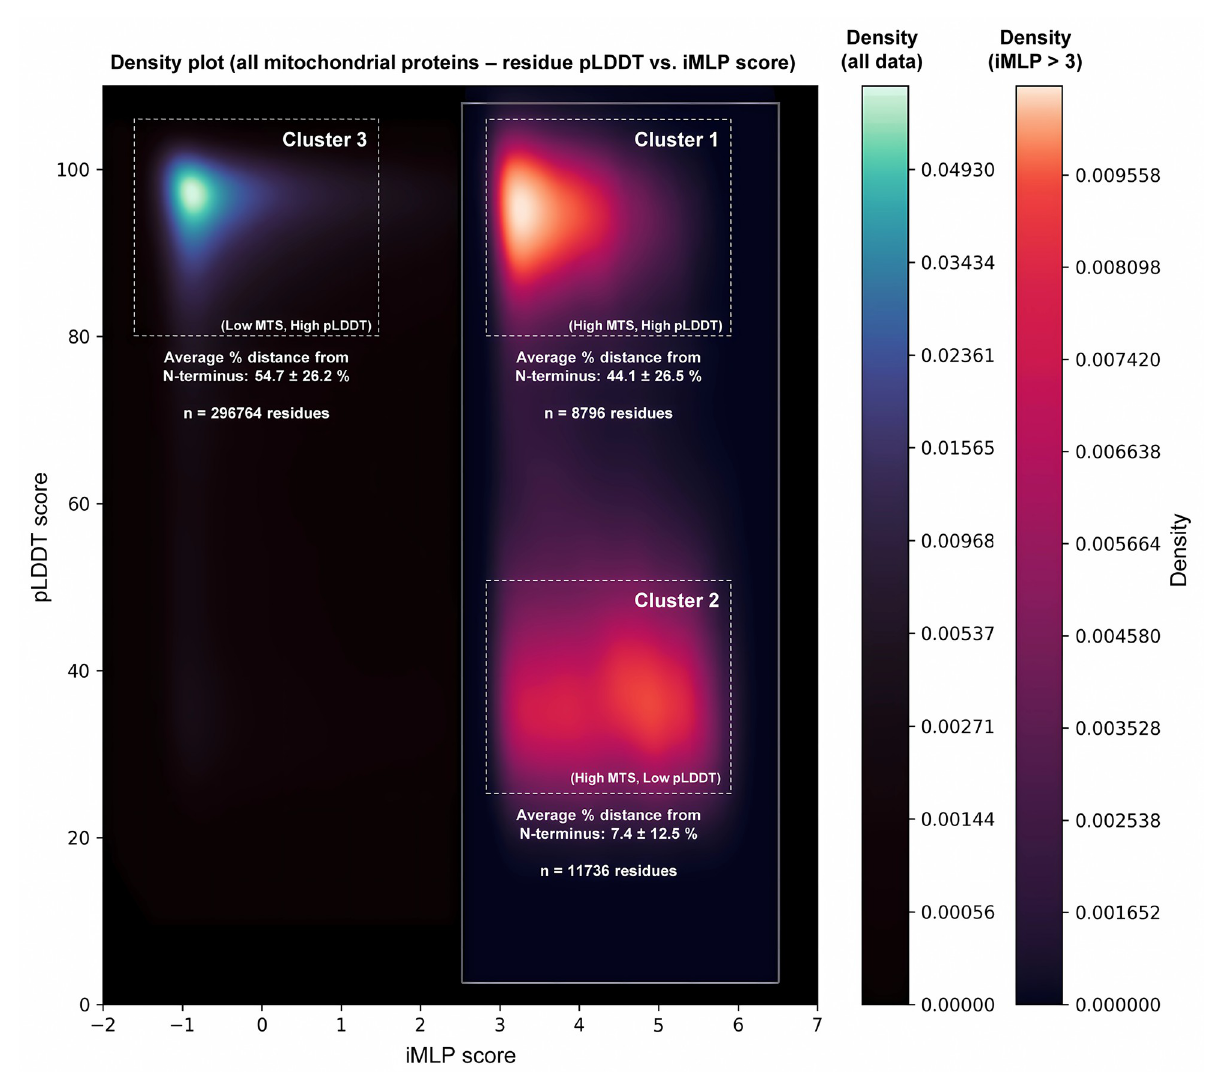
Fig 3. Global analysis of per-residue iMLP and pLDDT scores across the human mitochondrial proteome. AlphaFold pLDDT and iMLP scores were extracted on a per-residue basis (426832 residues total) for all 1136 proteins in the human mitochondrial proteome and were visualized as a kernel density estimate (KDE) plot using the seaborn library in Python. Two density plots were generated and merged to visualize low density datapoints—one for all pLDDT and iMLP scores (blue), and one for residues with high MTS propensity (iMLP score > 3) (red). Based on the KDE plot, data were grouped into three subsets (Cluster 1: pLDDT 80–100, iMLP > 3, Cluster 2: pLDDT 25–50, iMLP > 3, and Cluster 3: pLDDT 80–100, iMLP < 1.5) and the % distance of each residue within their corresponding protein length were calculated and written as the average % distance from N-terminus ± standard deviation for all residues in that